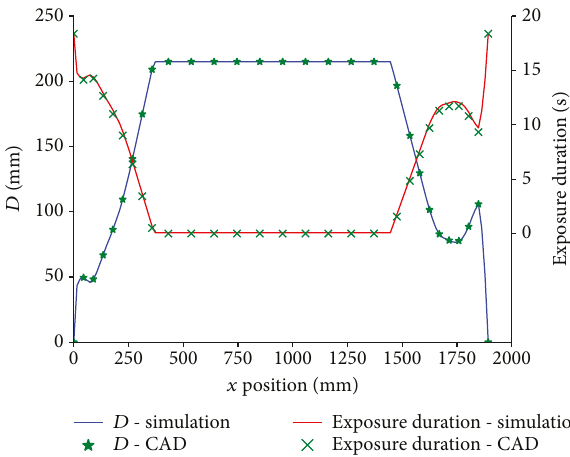
Figure 8: D and exposure duration on sampling sections ( n and n r = 180